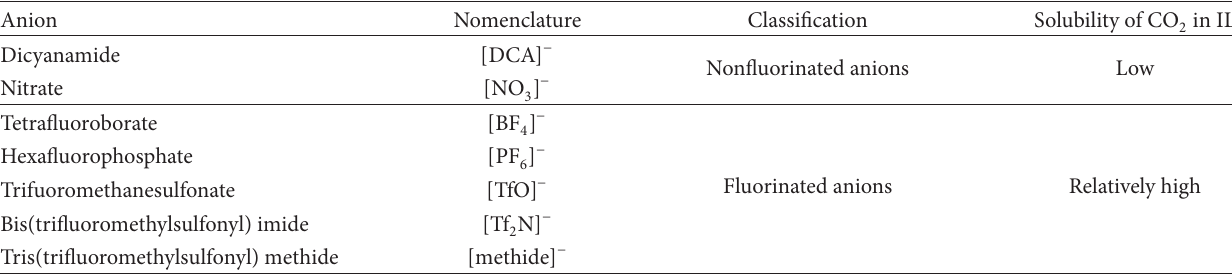
Table 3: Influence of anions in different ionic